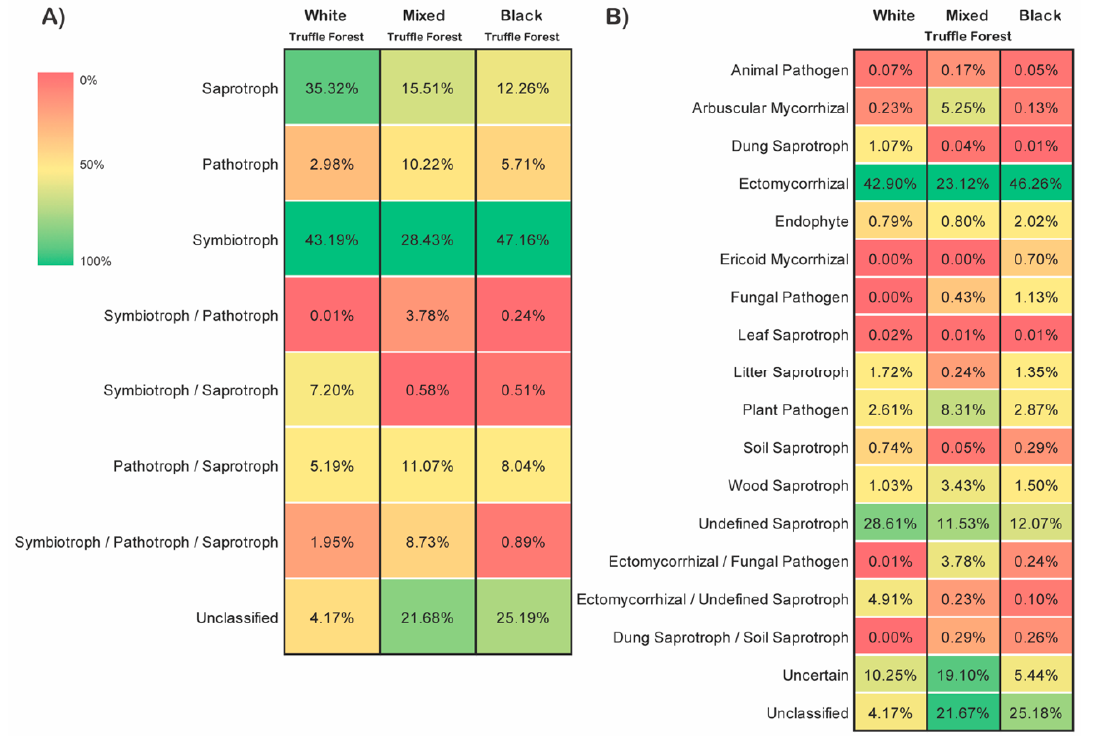
Figure 6. Relative abundance-based heat-maps of the fungal trophic modes ( A ) and functional guilds ( B ) inferred by FUNGuild in white, mixed and black truffle-producing forests in Serbian riparian forests. The values in each color block represents the relative abundance (%) of the respective trophic mode or functional guild.